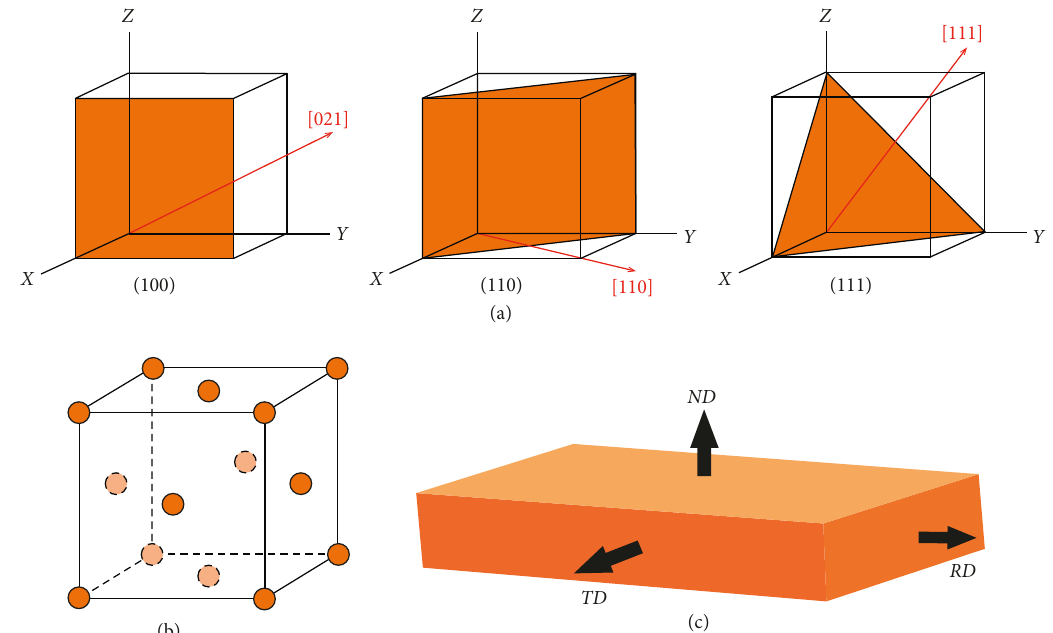
Figure 3: (a) Examples of Miller indices for planes (in orange) and vectors (in red) for a simple cube, (b) face-centered cubic crystal (FCC), and (c) definition of the metallurgical directions of a sample that has been worked: ND � normal direction, RD � rolling direction, and TD � transverse